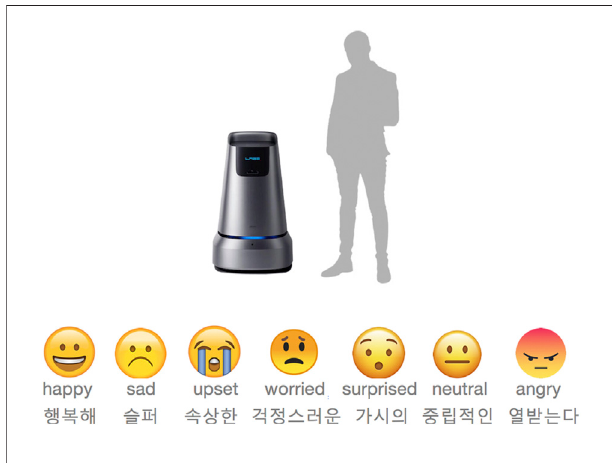
FIGURE 1A | Snippet of the questionnaire fi lled by the employees regarding their perception about the robots.